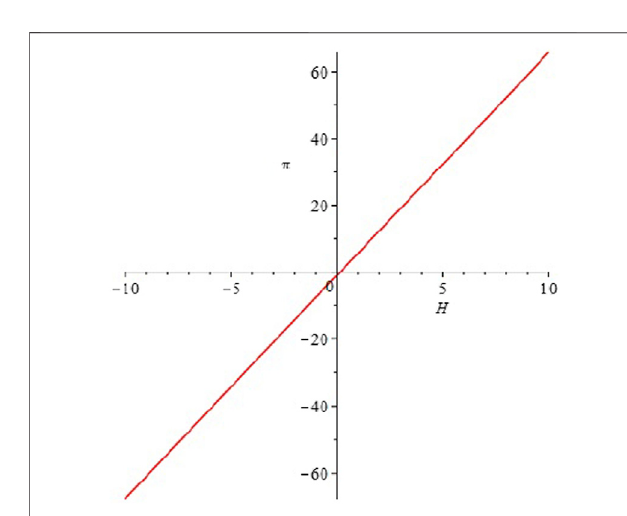
FIGURE 7 | The function image of the derivative of π 3 with respect to d . FIGURE 8 | The relationship between π